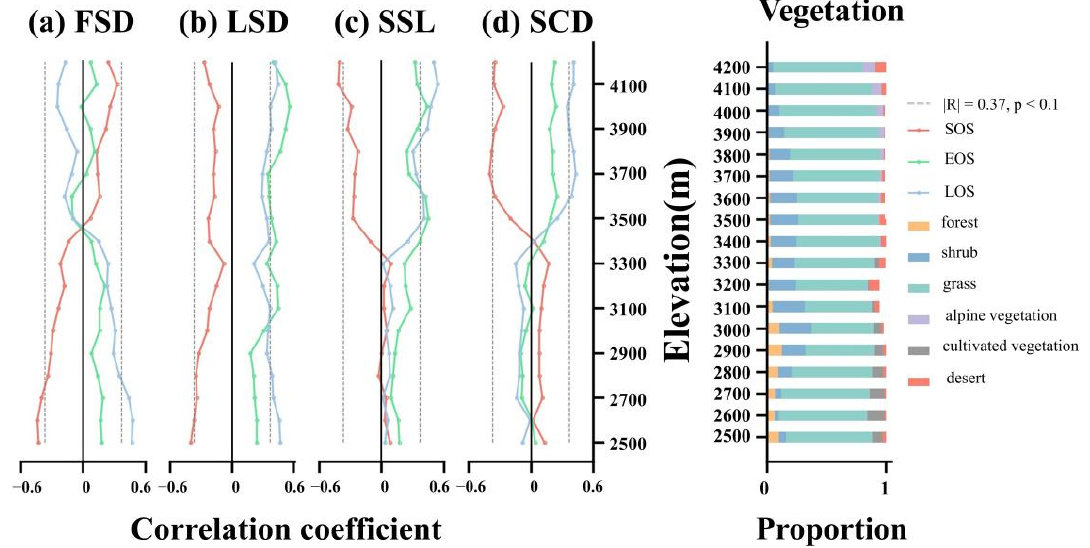
Figure 9. Left panel shows the land surface phenology metrics response to different snow seasonality metrics at different elevation. ( a ) means FSD, ( b ) means LSD, ( c ) means SSL and ( d ) means SCD. Right panel shows the vegetation constitute at different elevations.